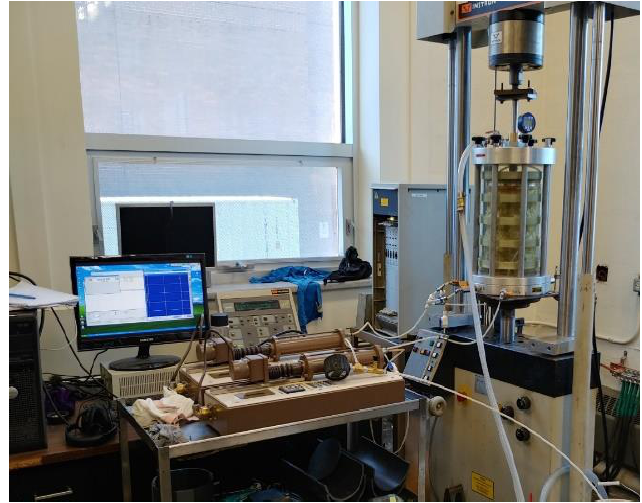
Figure 2. Cyclic triaxial test set up, adapted from Moussa and El Naggar [9].